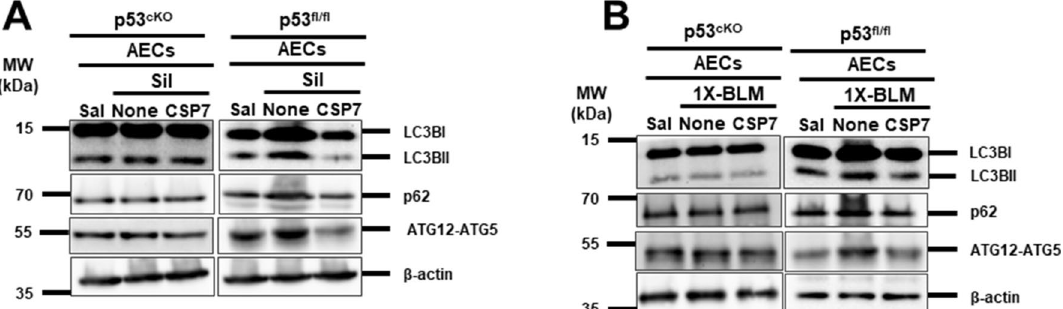
Figure 6. CSP7 regulates autophagy via p53 in AECs of mice with silica- and 1X-BLM-induced PF. ( A ) Representative Western blot images showing lipidation of LC3B (LC3BII) and expression of p62 and ATG12- ATG5 in AECs of p53 cKO and p53 fl/fl mice (n = 5–6 per group) exposed to silica and post-silica CSP7 treatment. β-actin serves as loading control. ( B ) Representative Western blot images showing the expression of LC3BII, p62 and ATG12-ATG5 in AECs isolated from p53 cKO and p53 fl/fl mice exposed to 1X-BLM. β-actin serves as loading control. MW: Molecular weight. kDa: Kilodalton. Each experiment was repeated at least 2 times with similar